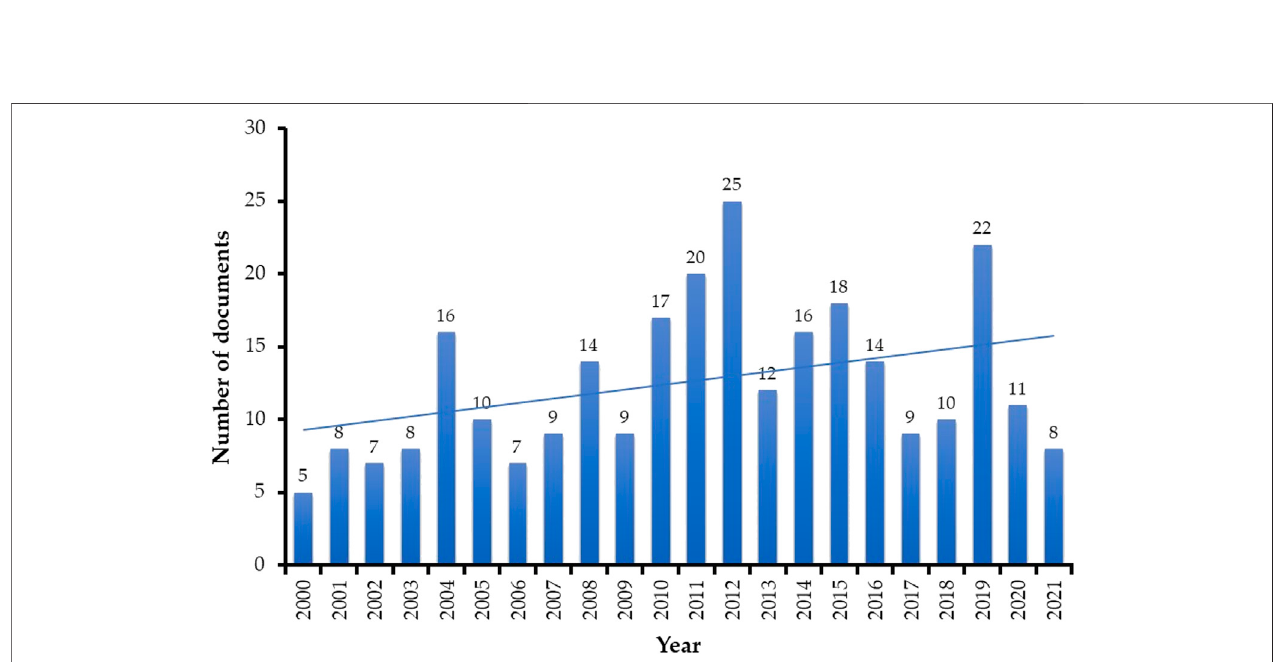
FIGURE 2 | Number of publications per year over the past two decades (2000 to May 2021) related to the impact of radiotherapy research on male fertility. The trendline signi fi es an overall steady increase in research focus on this fi eld throughout the last 20 years.